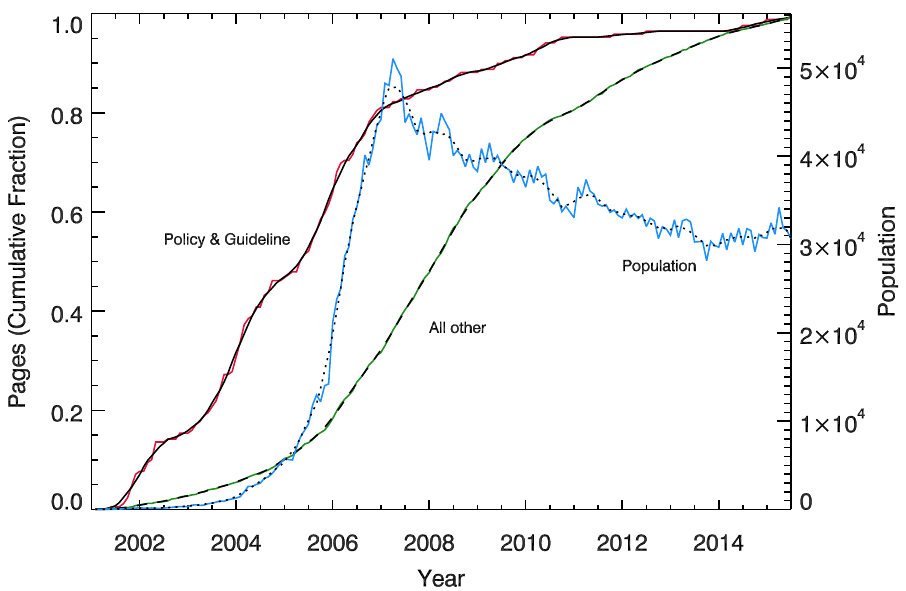
Figure 1. Cumulative growth in policy (red/solid line) and non-policy (green/dashed line) pages, overlaid on active population (blue/dotted line). Policy creation precedes the arrival of the majority of users, while the creation of non-policy pages, usually in the form of essay and commentary, lags the growth in